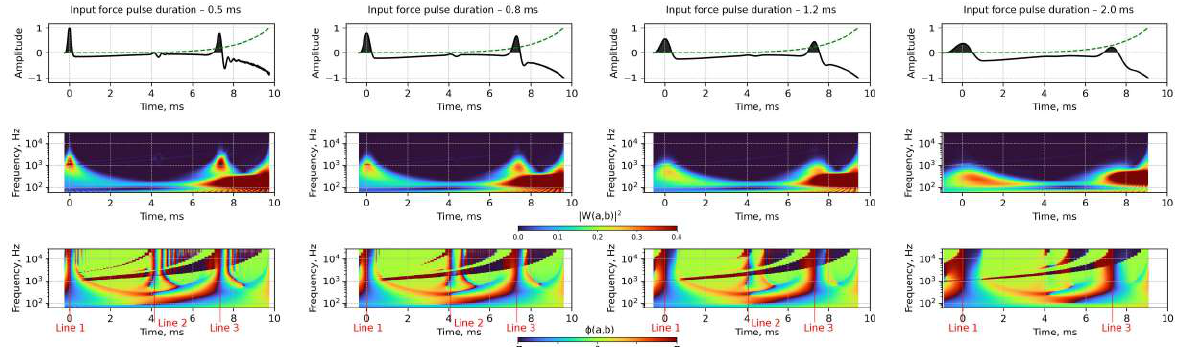
Figure 6. CCWT analysis of the low strain test numerical simulation results for a pile with a splice of 1 mm sand gap (Model 3) with input force pulses of 0.5, 0.8, 1.2, and 2 ms duration. 1st row—the simulated signals, 2nd row—the distributions of energy of the wavelet transform coefficients, 3rd row—the distributions of phase angles of the wavelet coefficients. Lines 1, 2, and 3 delineate the phase shift moments.